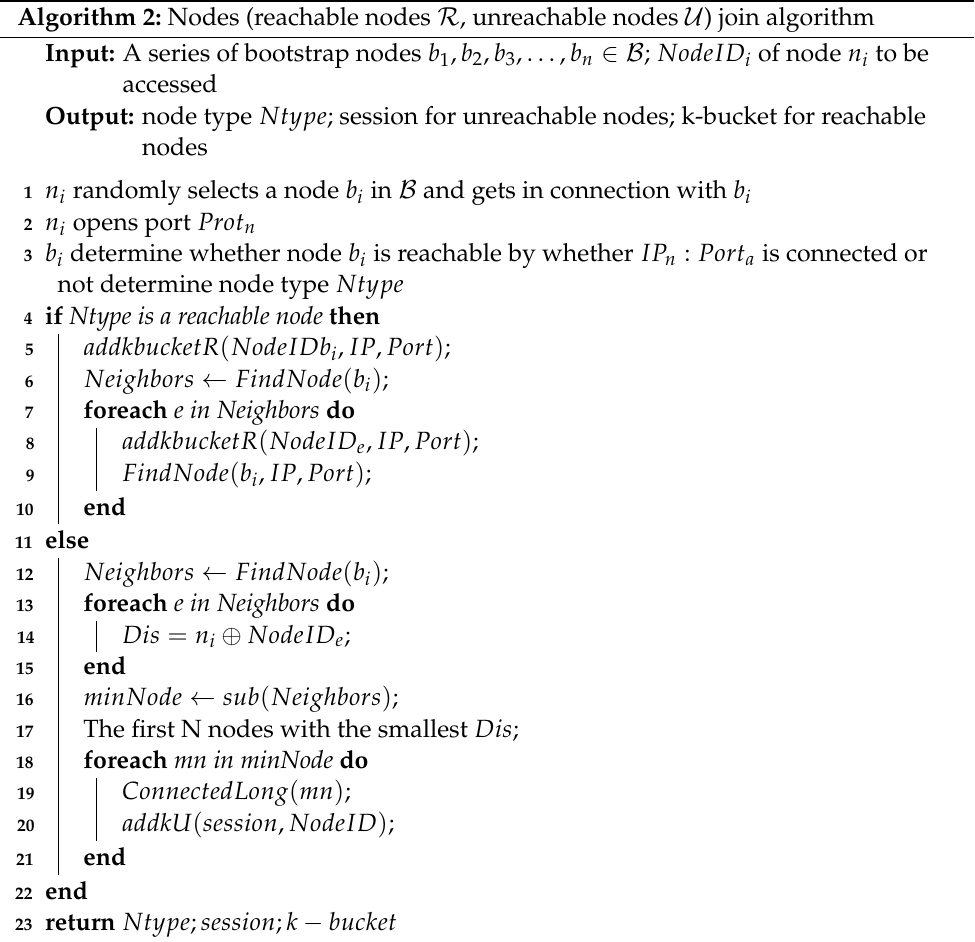
Algorithm 2: Nodes (reachable nodes R , unreachable nodes U ) join